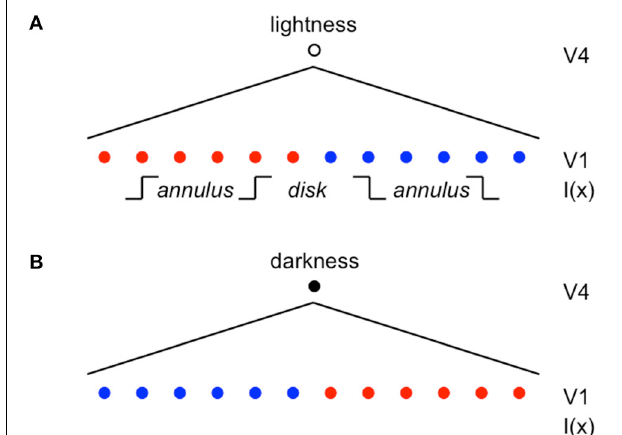
FIGURE 3 | Cortical architecture of the basic edge integration model showing its response to an incremental disk-annulus display. (A) Lightness neurons in V4 integrate the outputs of simple cells in V1 having asymmetric receptive fields that detect edges whose light sides point toward the lightness neuron’s receptive field center. The red dots indicate the positions of V1 neurons that respond to edges having higher luminance on the left side; and the blue dots indicate the positions of V1 neurons that respond to edges having higher luminance on the right side. The diagonal lines fanning downward from layer V4 to layer V1 schematically represent the V4 receptive fields that spatially integrate the outputs of V1 neurons to edges of appropriate contrast polarity in order to activate separate “lightness” and “darkness” units in V4 signaling the magnitudes of lightness and darkness at the location of the V4 receptive field centers. The linear receptive field profile should not be taken literally; the actual profile is unknown. In fact, the profiles is more likely to have the form of a decaying exponential because edge integration models that have been applied to disk-annulus stimuli suggest that edge weights fall off linearly with the logarithmic of distance to good approximation from the target (Rudd and Zemach, 2004). I(x) indicates the locations within the lightness neuron’s receptive field of the inner and outer annulus edges of a “double-increment” disk-annulus display, that is a display whose inner and outer annulus edges are both of the light-inside contrast polarity type, such as the one illustrated on the left side of Figure 2 (Rudd and Zemach, 2007). The labels “disk” and “annulus” indicate the locations of the disk and annulus regions in a one-dimensional cross-section of the disk-annulus display. (B) Darkness neurons in V4 similarly integrate the outputs of simple cells having asymmetric receptive fields that detect edges whose dark sides point toward the darkness neuron’s receptive field center. A double-increment disk annulus display contains no edges that stimulate a darkness neuron. In the most general case, some of the edges in a lightness display will excite lightness neurons, and some will excite darkness neurons. The achromatic color assigned to a given location in the image will depend on the difference in the excitation levels of the V4 lightness and darkness neurons whose receptive fields are centered on that location (Rudd,